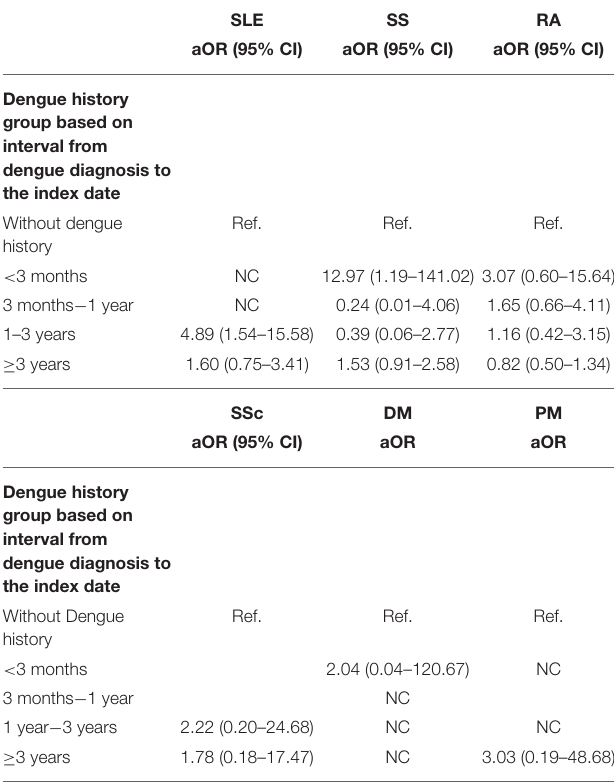
TABLE 4 | Associations between dengue history based on the interval from dengue diagnosis to the index date and the risk of systemic lupus